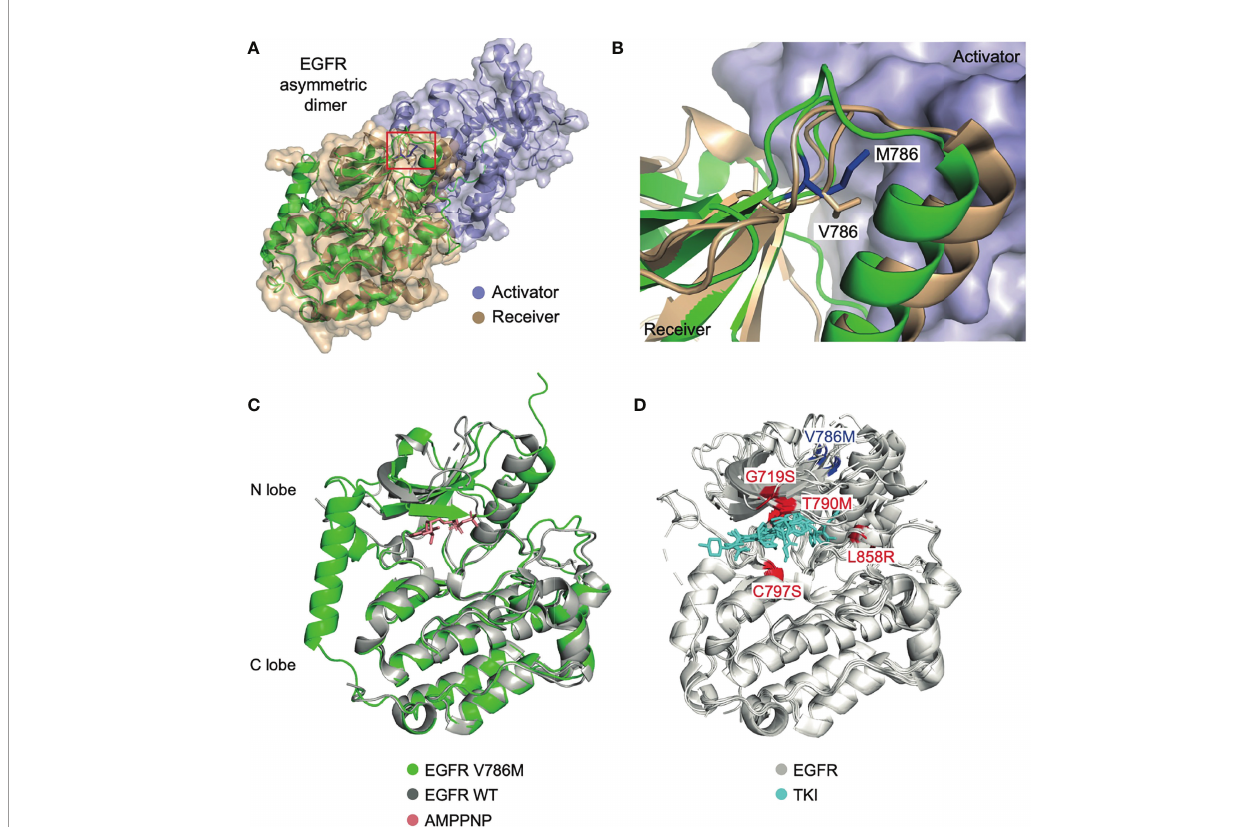
FIGURE 4 | EGFR V786M mutation may facilitate the dimerization of EGFR, while it does not affect the binding of TKI. (A) Structure of the EGFR TK domain in the asymmetry dimer (PDB: 4LL0). The activator kinase is colored in slate, the receiver kinase in wheat. The predicted 3D structure of the V786M mutation is shown in cartoon (green) with V786 indicated in a red box. The modeled complex structure of the EGFR : EGFR homodimer, in which the N-lobe of the fi rst EGFR (receiver) binds to the C-lobe of the second EGFR (activator) in a head-to-tail manner. (B) A close-up view of the dimer interface. M786 (blue) may strength the interaction between the EGFR dimer by protruding into the activator kinase domain (slate surface). (C) Structural alignment between EGFR V786M (green) and the wild-type protein (grey) with AMPPNP (red) bound (PDB: 3VJO). V786M induces conformational change in the N lobe region. (D) Analysis of EGFR mutations (PDB: 5ZWJ, 5GNK, 5GTY, 4ZAU, 4I22, 3UG2, 5Y9T, 6LUD). V786M locates in a different position from previously reported EGFR mutations which affects the binding of TKI (cyan) such as G719S, T790M, C797S, and L858R (highlighted in red). TK domain; tyrosine kinase domain. TKI, tyrosine kinase inhibitor; WT,